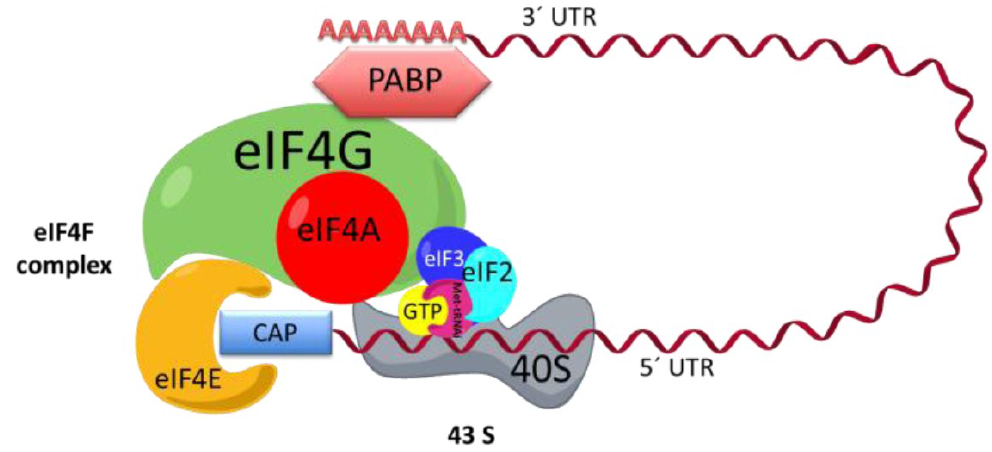
Figure 1. Initiation complex. The interaction between the eIF4F complex, 43S, and mRNA is shown. EIF4F is formed by eIF4A, eIF4G, and eIF4E. The complex 43S is formed by eIF3, the small ribosomal subunit, and eIF2, which in turn is formed by methionine-tRNA-initiator (Met-tRNAi) and GTP. The mRNA is recruited to the eIF4F complex across the interaction of the 3′ end and poly-A-binding protein (PABP) and the 5′ cap and eIF4E. UTR: untranslated